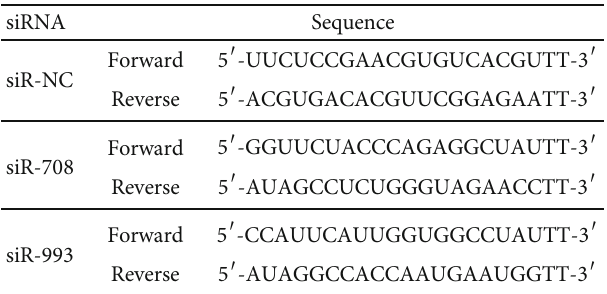
Table 2: Small interfering RNA sequence for B7-H6 knockdown.